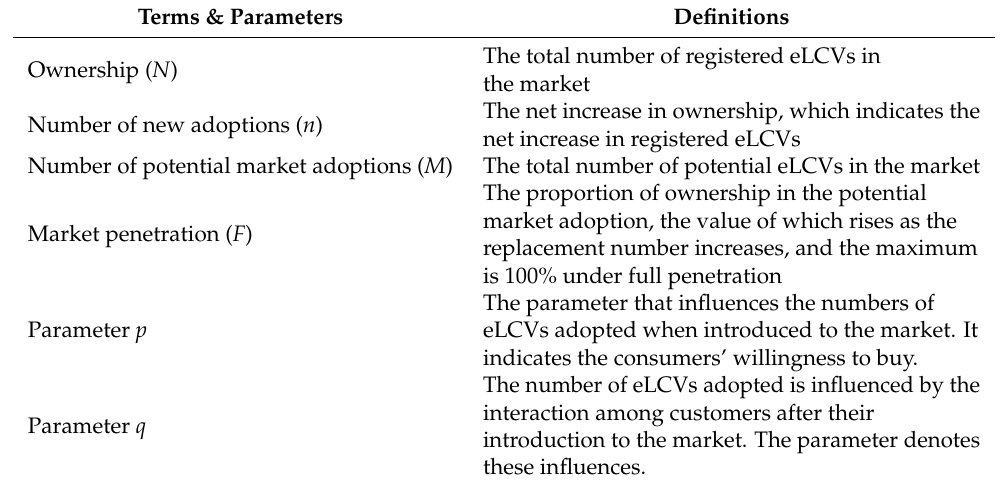
Table 3. Definitions of terms for the Bass Diffusion Model and its